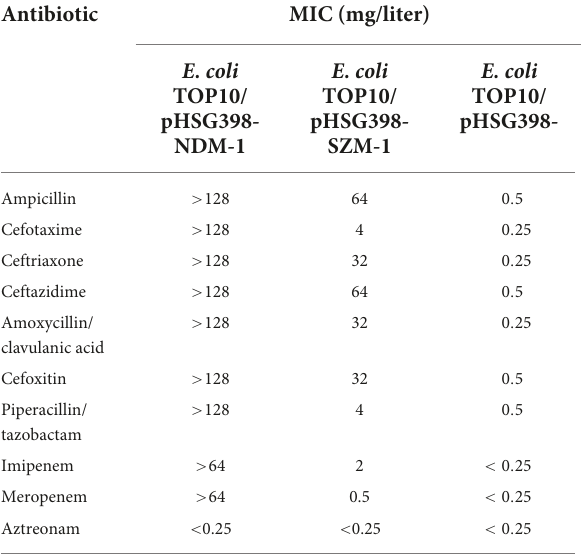
TABLE 1 Antimicrobial drug susceptibility